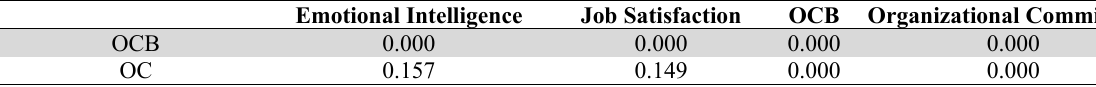
Standardized Indirect Effects (Group number 1 - Default model)